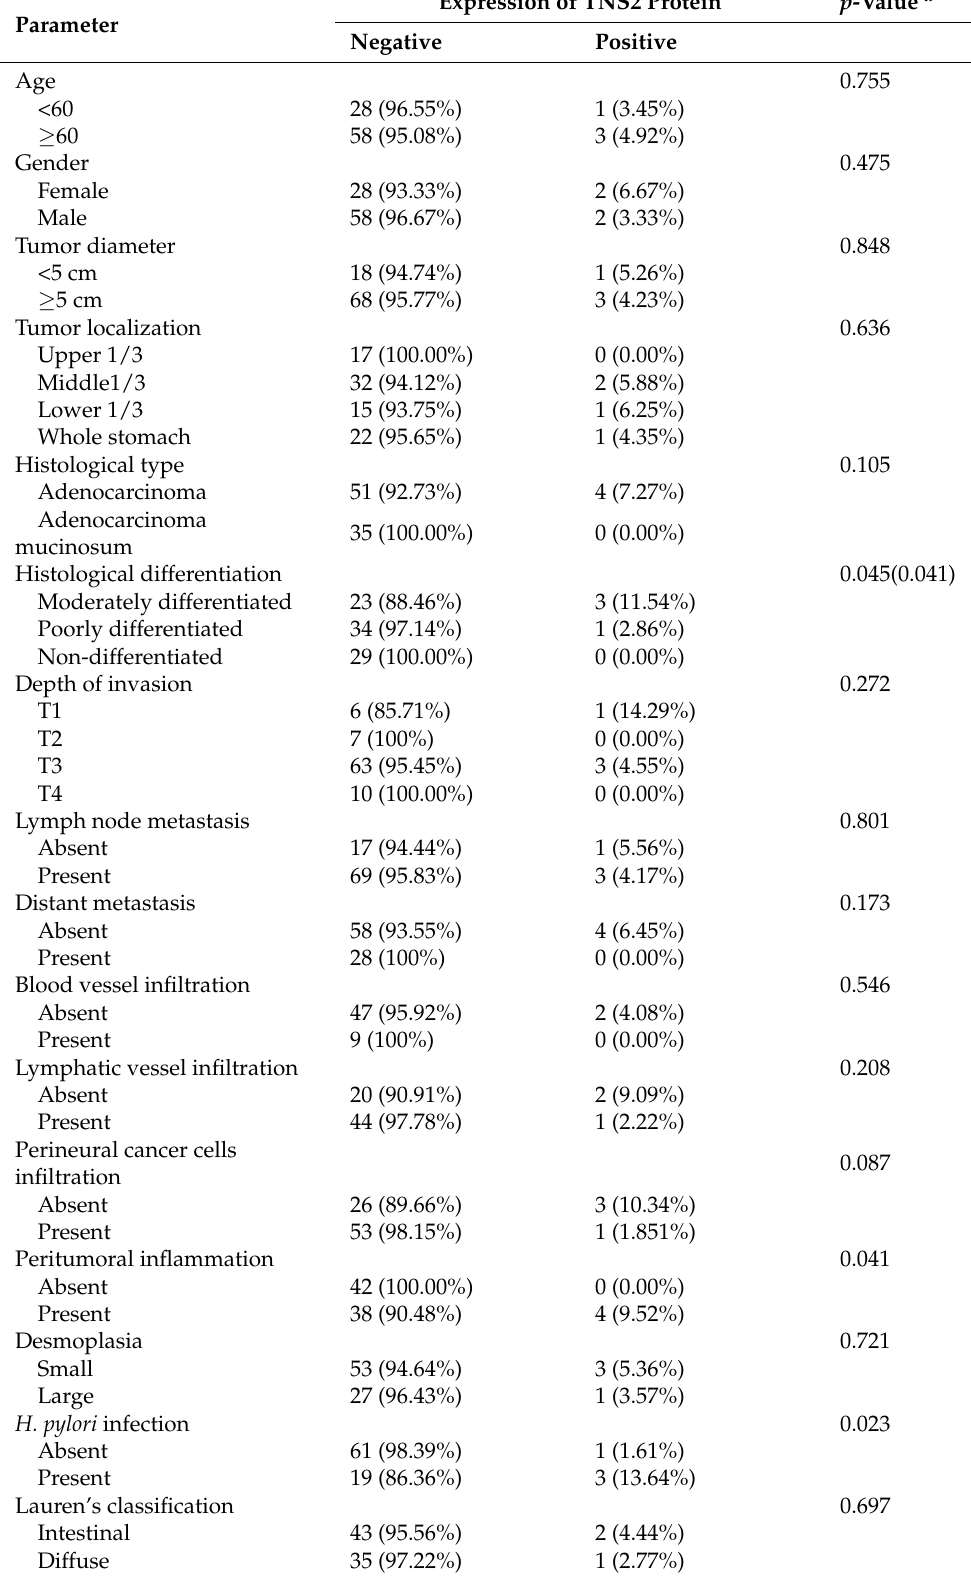
Table 3. Correlation between TNS2 protein expression level in gastric cancer and clinicopathologi- cal